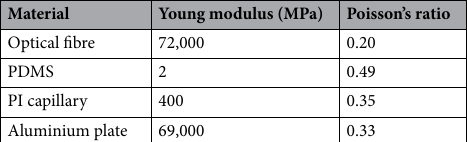
Table 1. Parameters used in the 3D-FEM-based